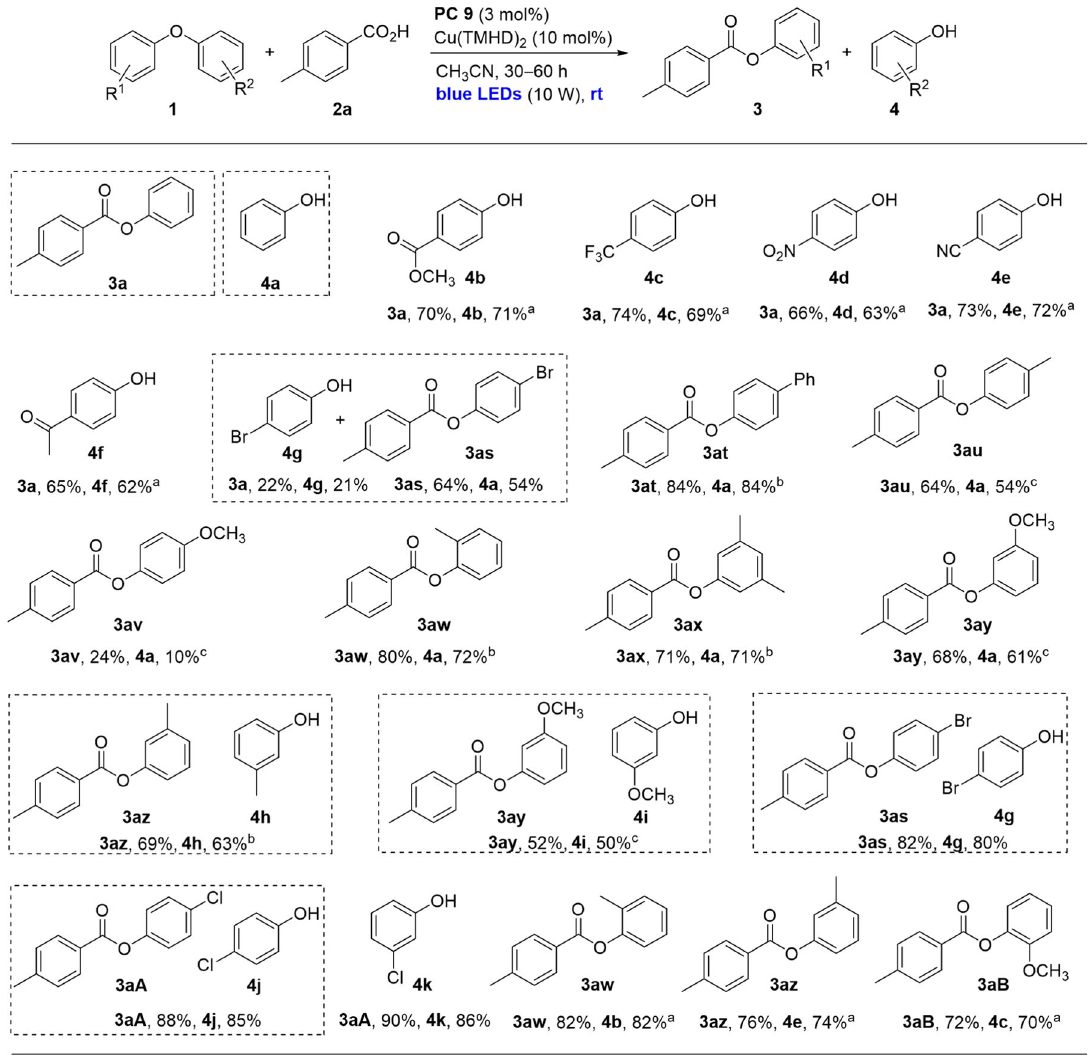
Fig. 4 Substrate scope of diaryl ethers. Reaction conditions: 1 (0.5 mmol), 2a (0.6 mmol), PC 9 (3 mol%), Cu(TMHD) 2 (10 mol%), CH 3 CN (5 mL), irradiation with blue LEDs (425 – 430 nm, 10 W) for 30 h. Isolated yields were reported. a 60 h. b CH 3 CN (5 mL) and PhCF 3 (2.5 mL), 60 h. c 1 (0.2 mmol), 25 W) irradiation for 60 h.